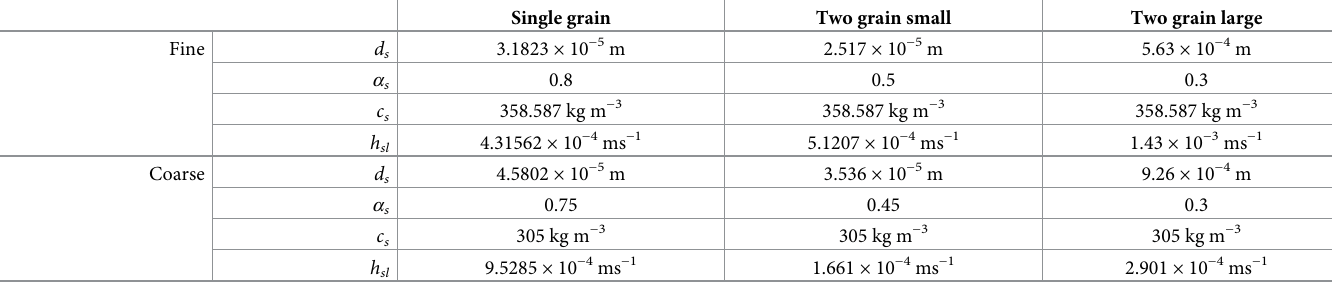
Table 2. Coffee grain parameters for fine and coarse grinds for both single grain and two-grain CFD and 1-D models.